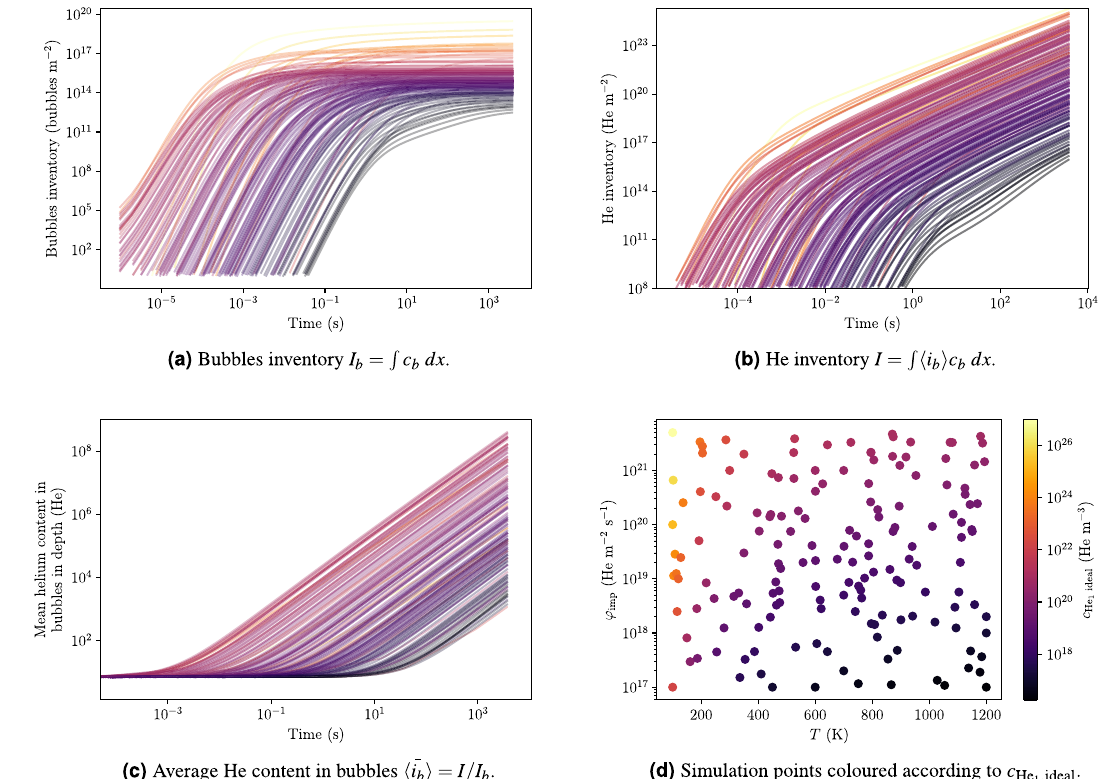
Figure 7. Temporal evolution of quantities in W exposed to 100 eV He at 10 22 m − 2 s − 1 and 1000 K for temperatures varying from 120 K to 1200 K and implanted fluxes varying from 10 17 m − 2 s − 1 to 10 21 m − 2 s − 1 . Each line corresponds to a simulation point (grey crosses on Fig. 6a and points on d ). The lines are coloured according to the parameter c